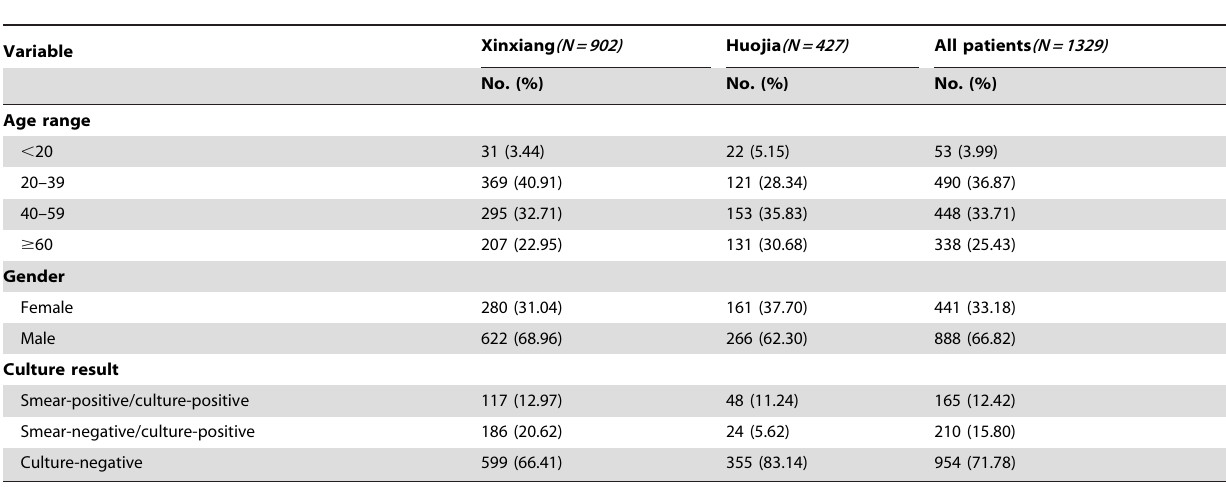
Table 1. Demographic information for the participants who were